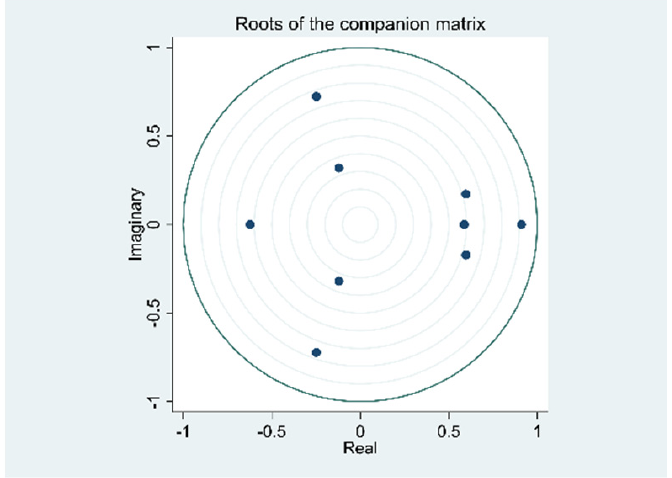
Figure 3. Balance test of data concerning the electricity consumption of the secondary sector.